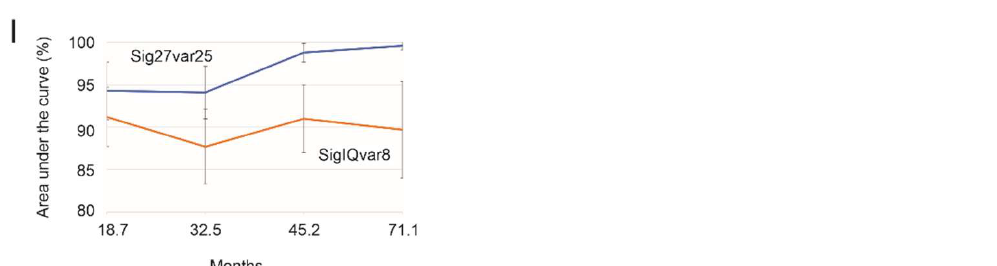
Figure 1. Effective prediction of poor OS of ACC by Sig27var25 and SigIQvar8. ( A ) Hazard ratio (HR), 95% confidence interval (CI), and p values for the indicated multigene signatures in predicting poor OS. ( B ) Stratification of fatality risk by Sig27 and SigIQGAP1NW. Cutoff points were